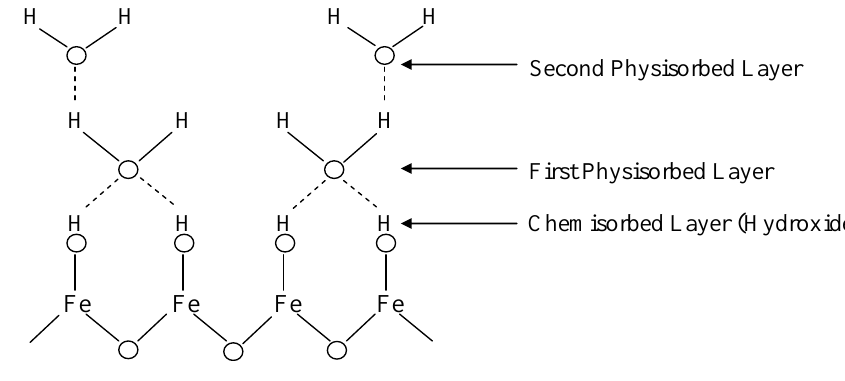
Figure 5. Multilayer structure of adsorbed water vapour molecules on the surface of iron oxide